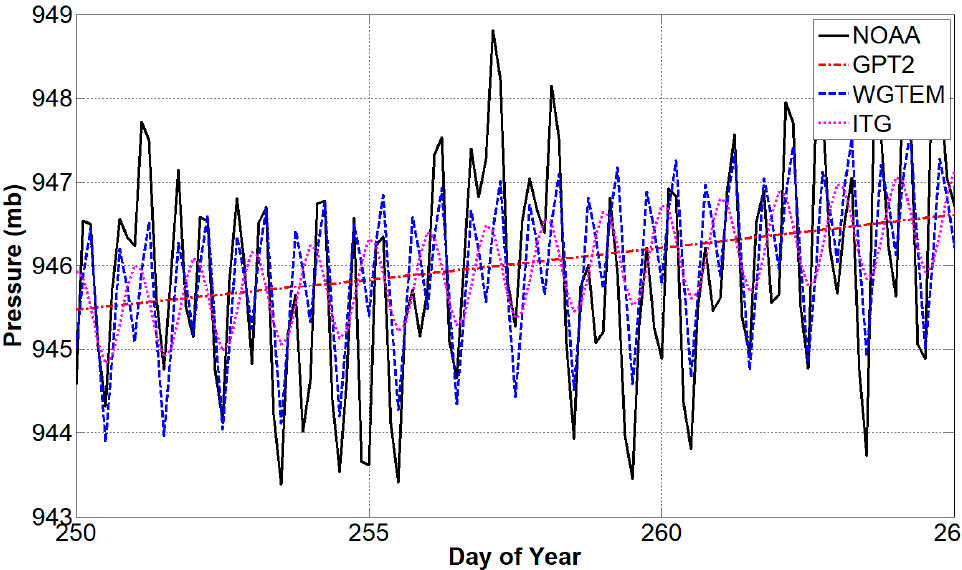
Figure 3. Air pressure time series from National Oceanic and Atmospheric Administration (NOAA) and three models at meteorological station in Begumpet during day of year (DOY) 250–264 in 2012.